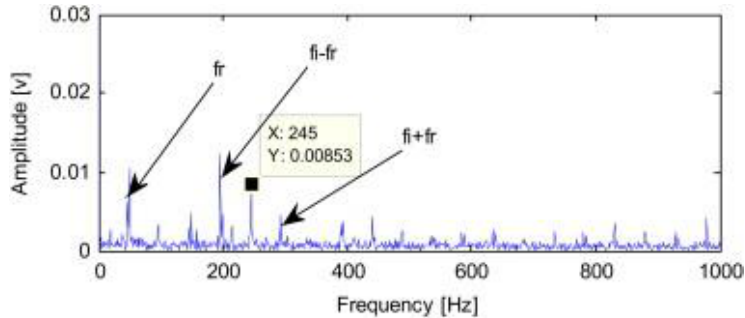
Figure 18. Envelope demodulation spectrum of IMF5 handled with RSSD [68].